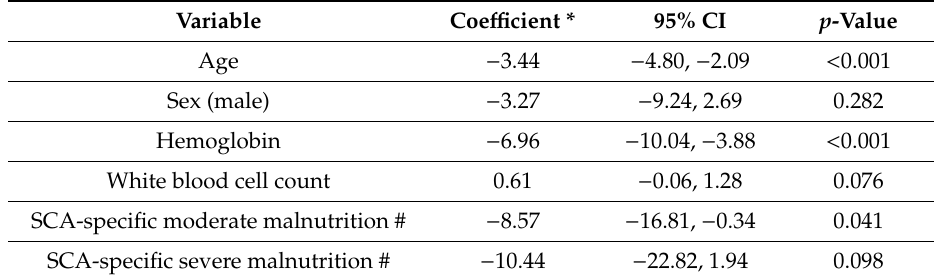
Table A1. Quantile regression model for transcranial doppler measurements in children with sickle cell anemia with SCA-specific malnutrition categories ( n = 701). Moderate malnutrition is associated with a decline of − 8.6 in TCD ( p = 0.041), controlling for age and other relevant